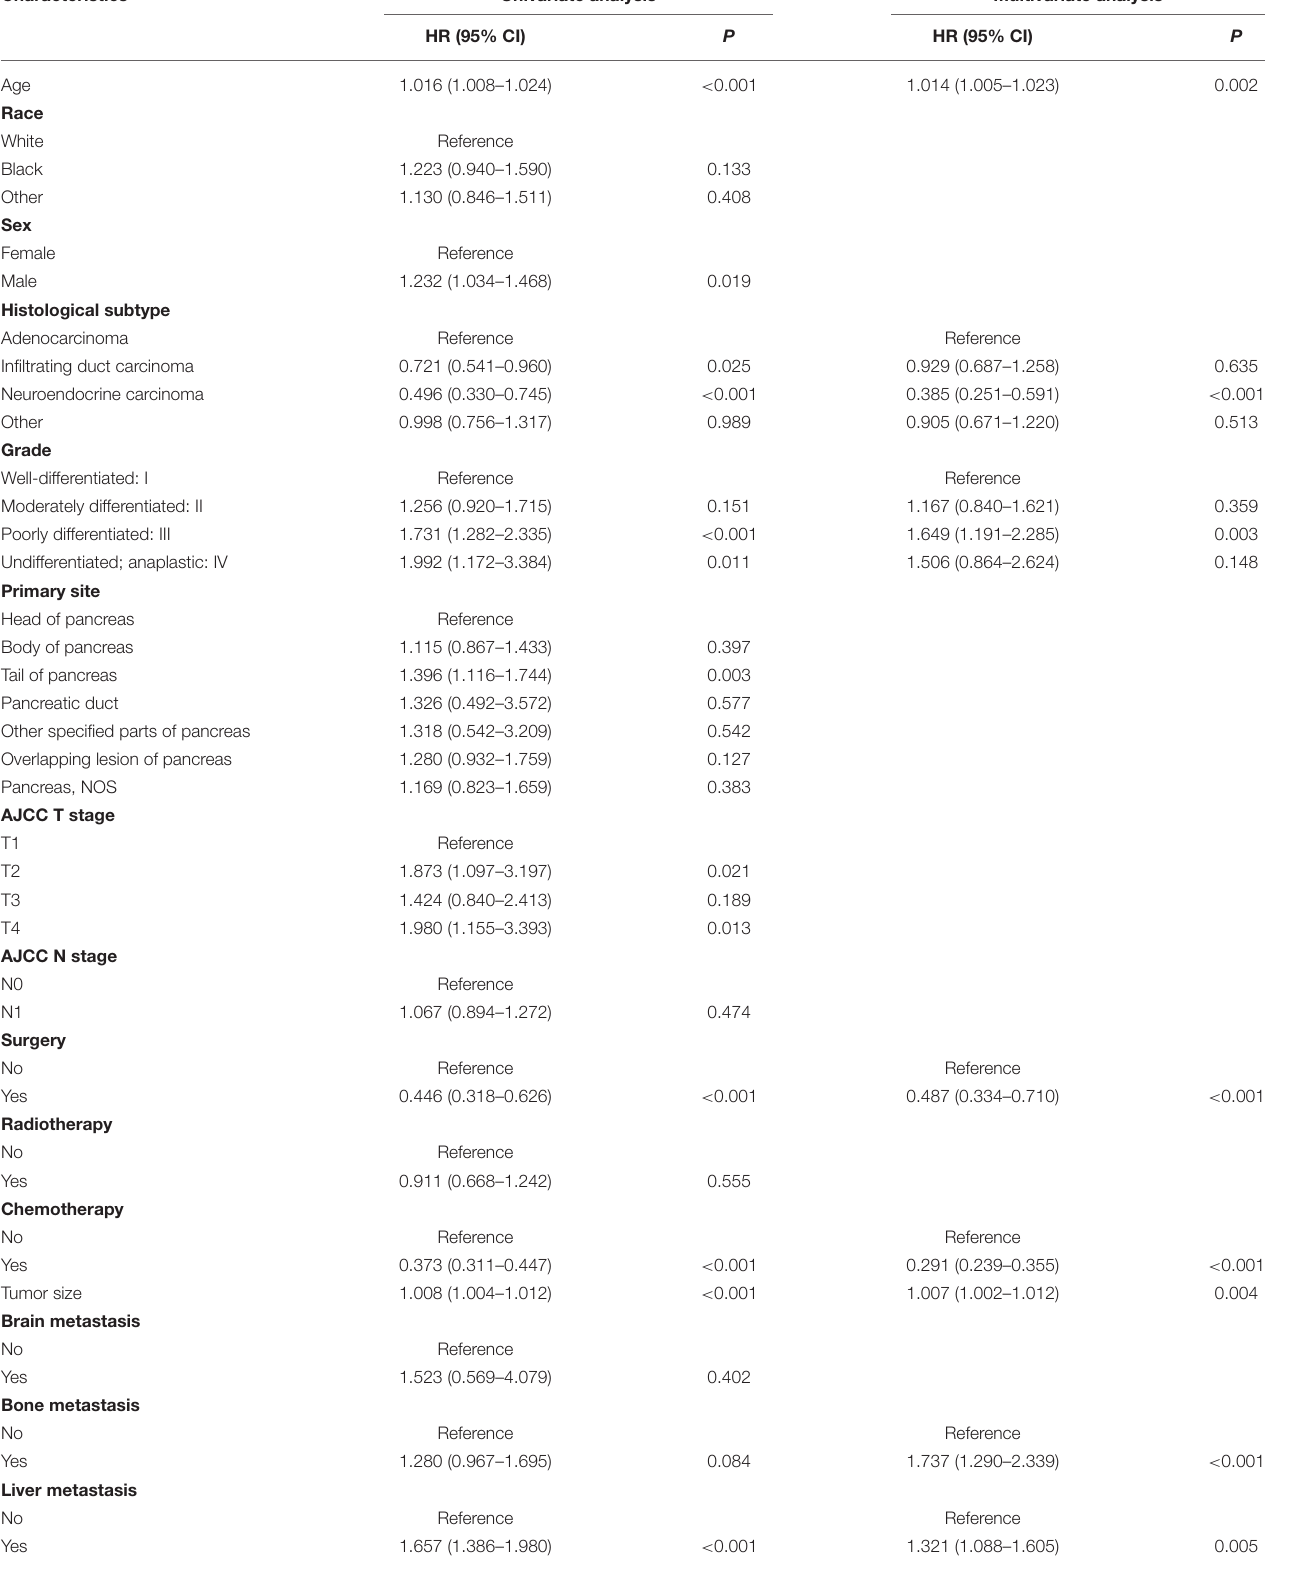
TABLE 5 | Univariate and multivariate Cox regression of prognostic factors of lung metastasis in pancreatic carcinoma patients.